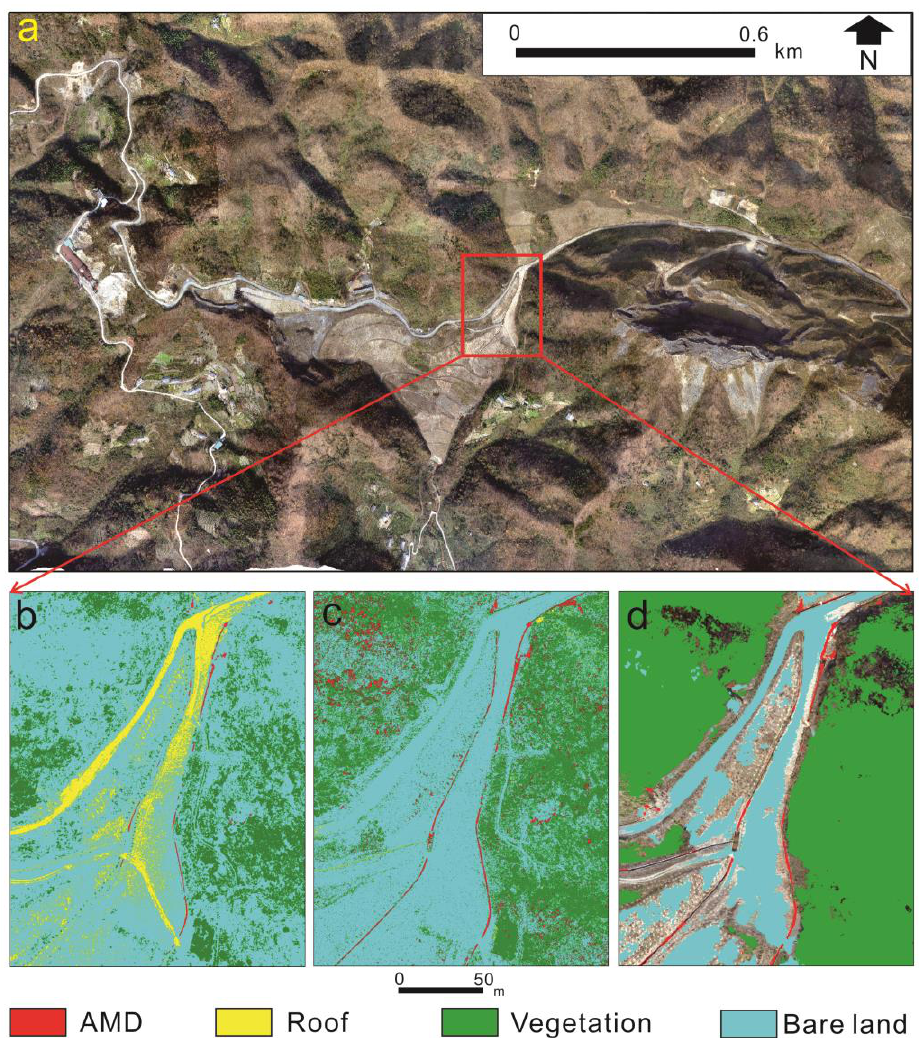
Figure 10. The classification map of U-Net method.(( a ) the UAV image of the study area, ( b ) SVM classification, ( c ) RF classification, ( d ) U-Net classification).